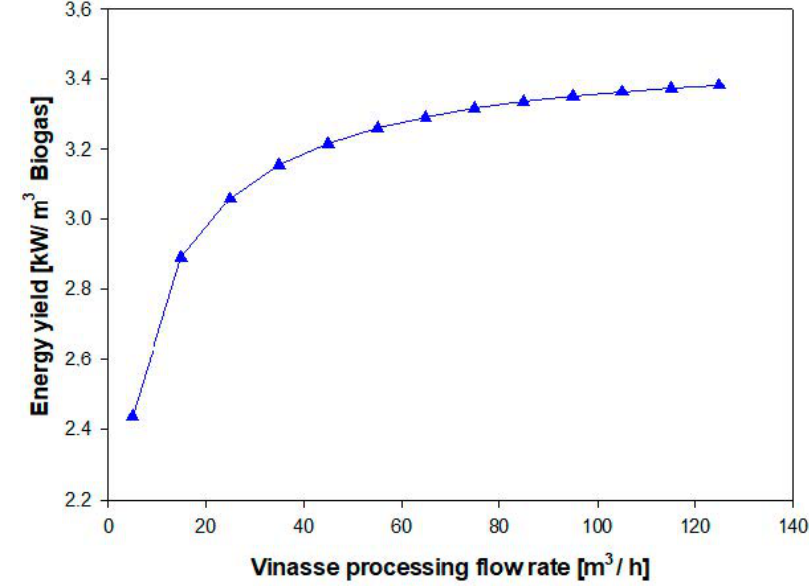
Figure 4. Effect of the vinasse processing flow rate on the electrical energy yield of an AD plant.